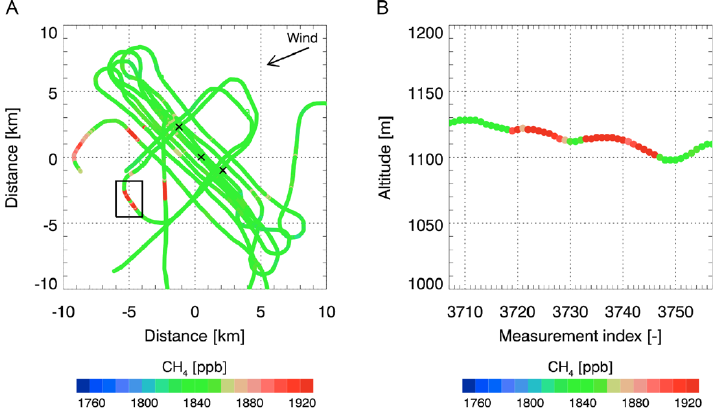
Fig. 9. Panel (A) : methane data from the in situ probe averaged for 1s. Data from the furthest part of the plume as indicated by the black box are shown in panel (B)